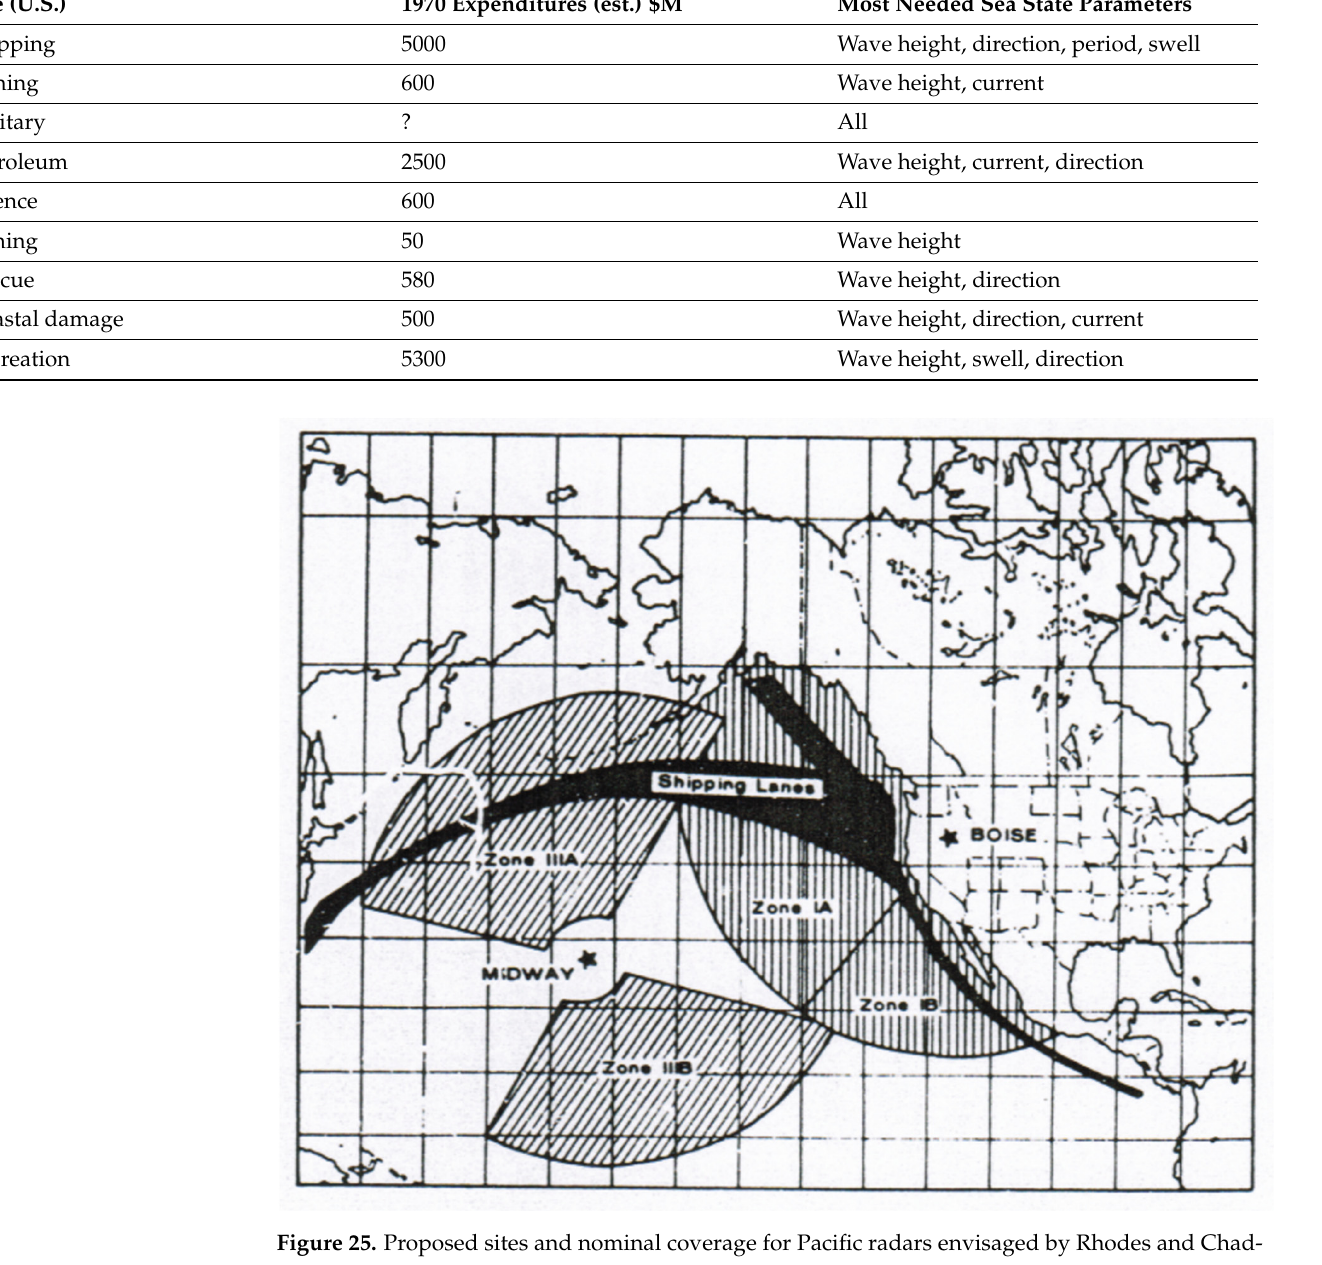
Figure 26. Proposed sites and nominal coverage for Atlantic radars envisaged by Rhodes and Chad- wick [101] .